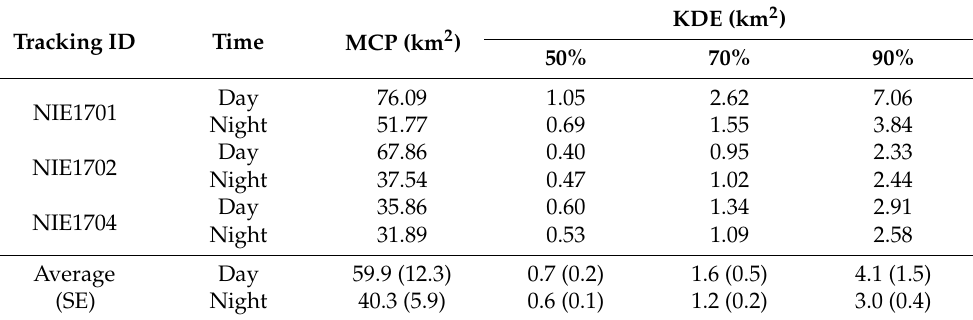
MCP = Minimum Convex Polygon, KDE = Kernel Density Estimate, SE = Standard